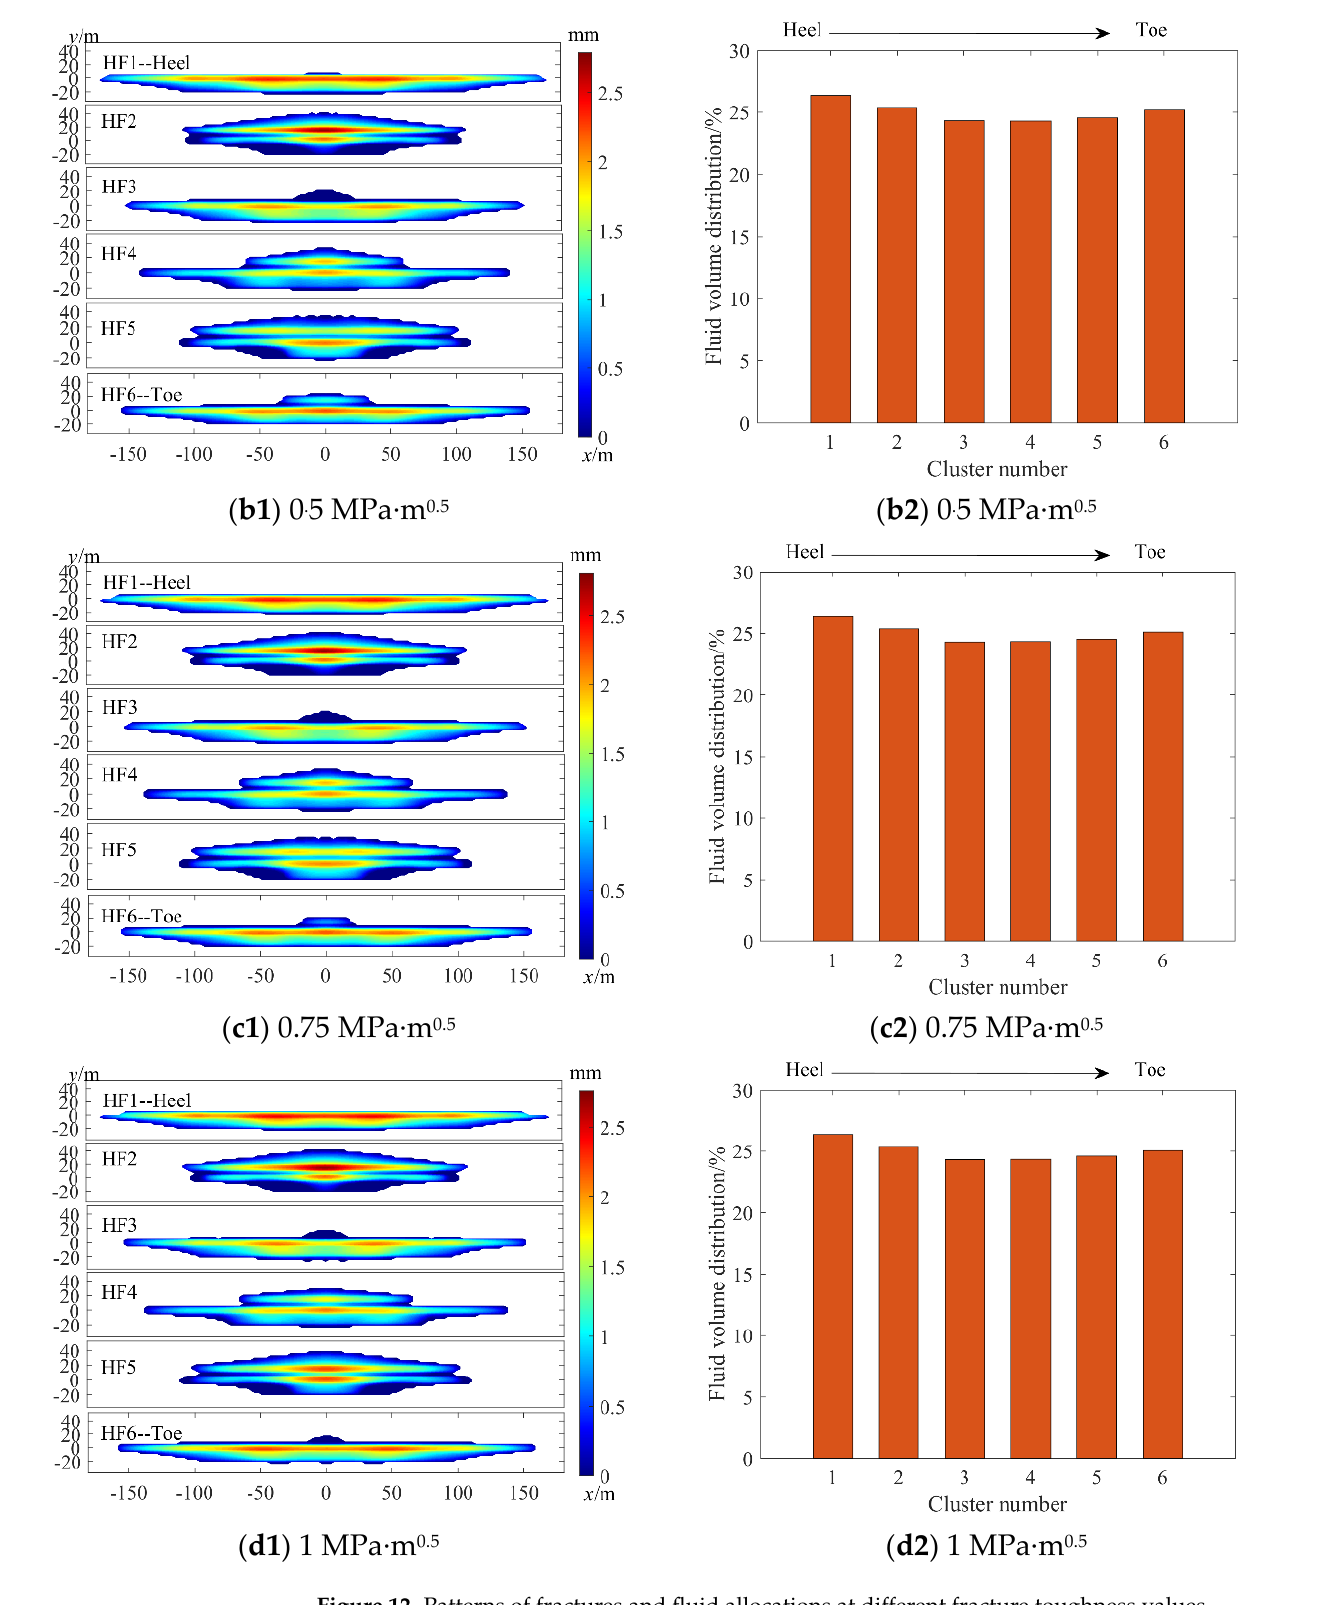
Figure 12. Patterns of fractures and fluid allocations at different fracture toughness values.